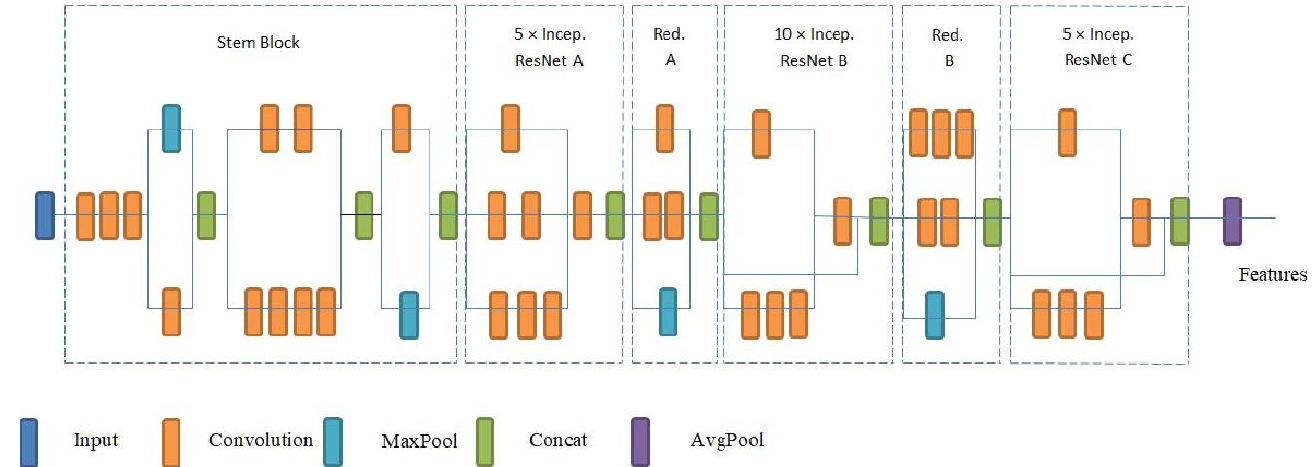
Figure 8. Inception-ResNetV2 architecture [30] .